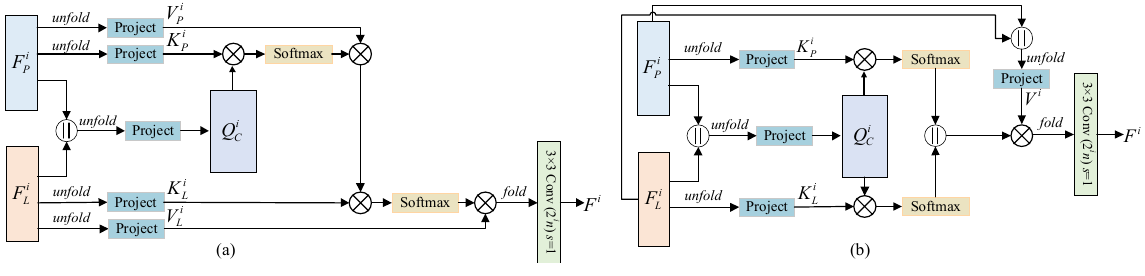
Figure 10. Different variants of SIAM. ( a ) SCAM; ( b ) SGAM.